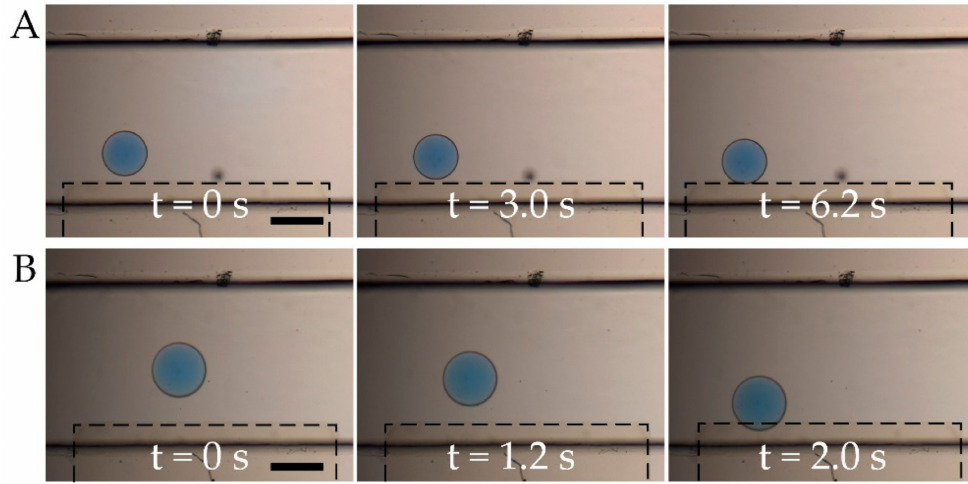
Figure 5. Influence of droplet DEP response on droplet core conductivity (Movie S2). ( A ) Low core conductivity, 15 mS / m; ( B ) High core conductivity, 1.5 S / m. Scale bar, 300 µ